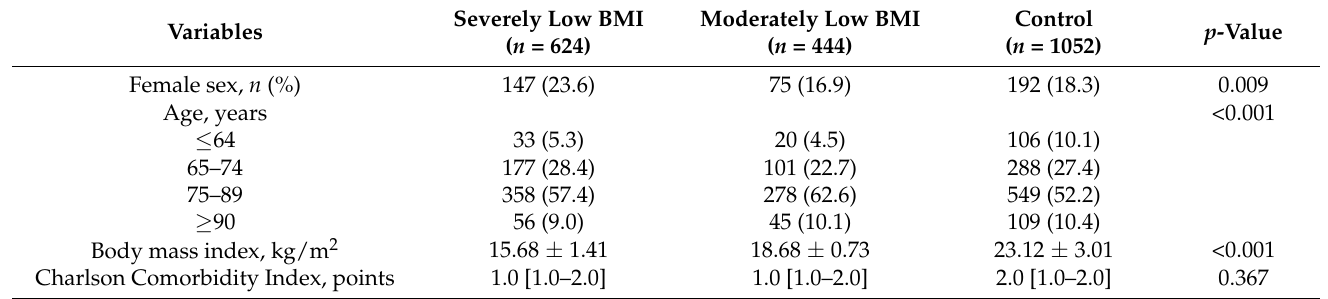
Table 1. Baseline characteristics of patients with acute exacerbations of COPD by the severity of low BMI in